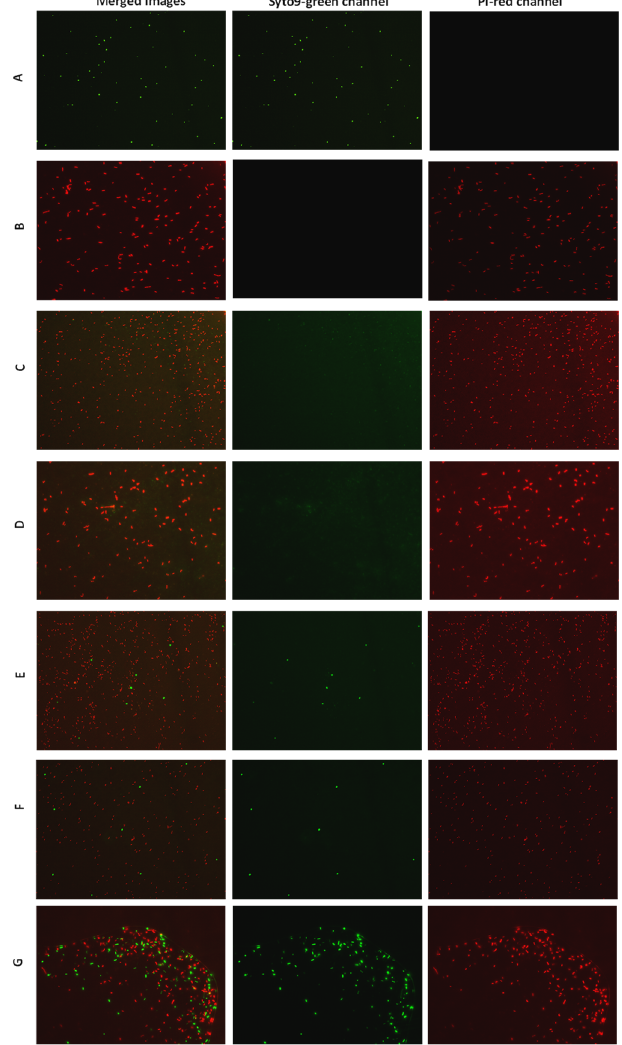
Figure 4. Fluorescence microscopy micrographs showing the effect of KL29 on Xanthomonas campestris pv. campestris cells treated with different concentrations: ( B ) 100 µM; ( C ) 50 µM; ( D ) 25 µM; ( E ) 12.5 µM; ( F ) 6.25 µM; ( G ) 2 µM. ( A ) untreated cells. Magnification 40X.